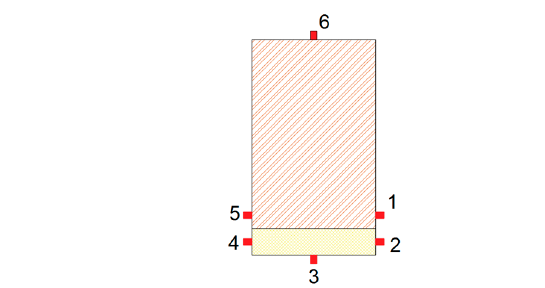
Figure 1. Reinforced beam design and four-point bending test set-up. Distances in mm. Materials 2019 , 12 , x FOR PEER REVIEW